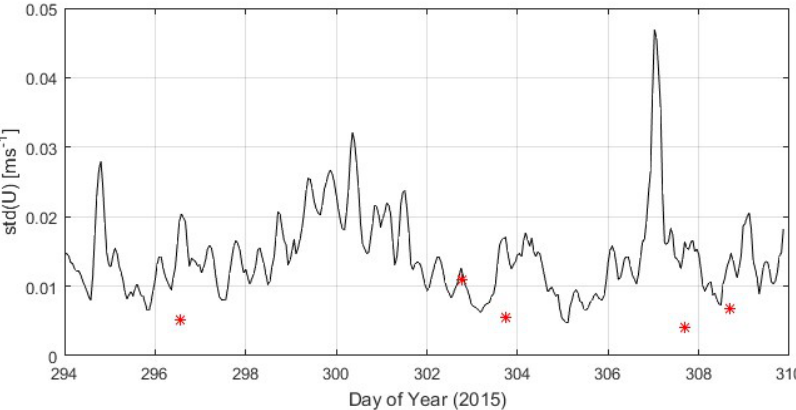
Figure 9. Standard deviation of the turbulent velocity on the scales between 100 and 500 m. Black line corresponds to ADCP measurements at 10 m depth, red asterisks are airborne dye plume velocimetry estimates.